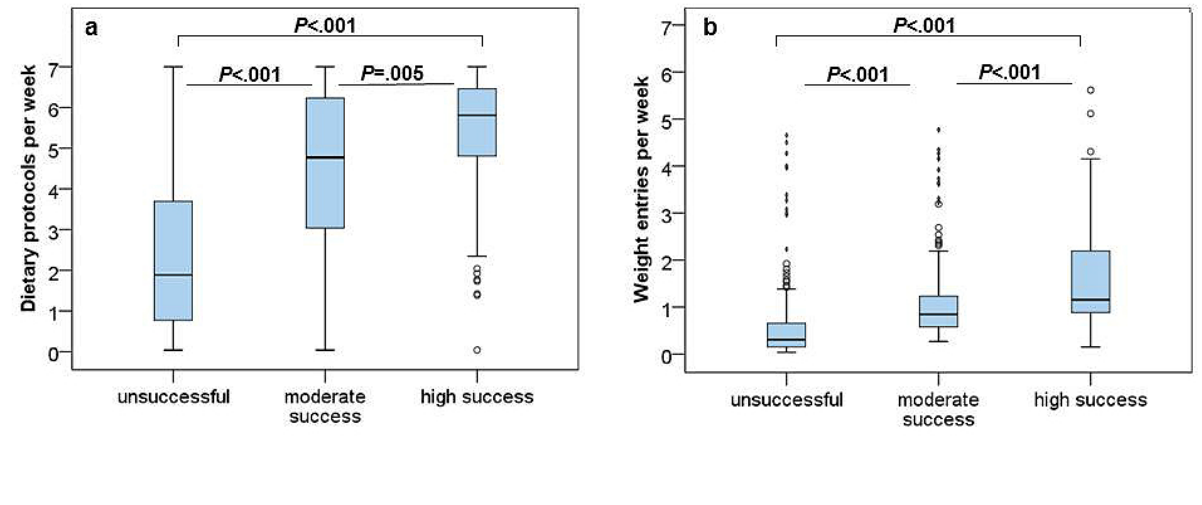
Figure 5. Use of program tools in the success groups during the first 6 months of program usage. Weekly number of dietary protocols (a) and number of weight entries (b) differed significantly among the unsuccessful (<5% weight loss), moderate success (5%-9.9% weight loss), and high success ( ≥ 10% weight loss) groups.